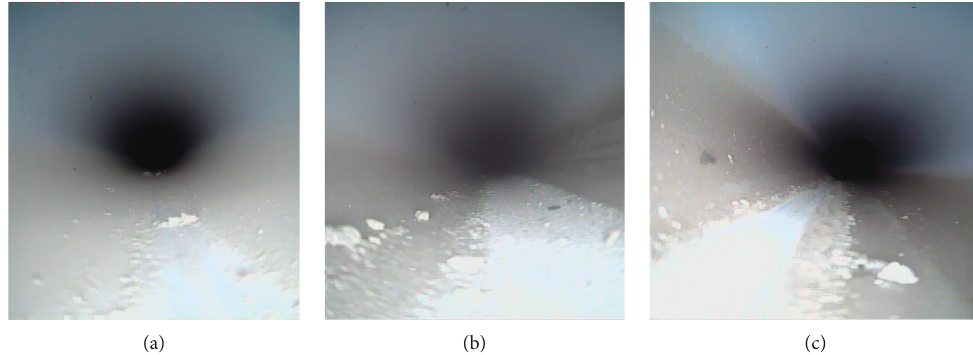
Figure 13: Polytetrafluoroethylene coated pipe. (a) October 28, 2016. (b) January 28, 2017. (c) April 28, 2017.